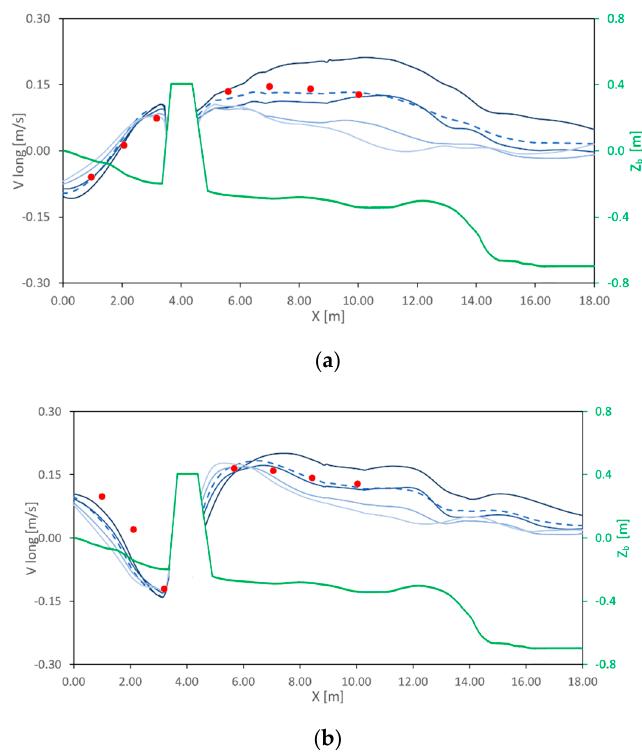
Figure 10. Long-shore currents at Y = 22 m ( a ) and Y = 26 m ( b ). Dashed blue line: depth-averaged velocity field computed by the proposed model. Solid blue lines: velocity fields computed by the proposed model at a relative position from the free surface z / z b = 0.133, z / z b = 0.400, z / z b = 0.667, z / z b = 0.933, from lightest blue to darkest blue. Red circles: experimental results obtained by Gravens and Wang [33]. Green line: bottom elevation.